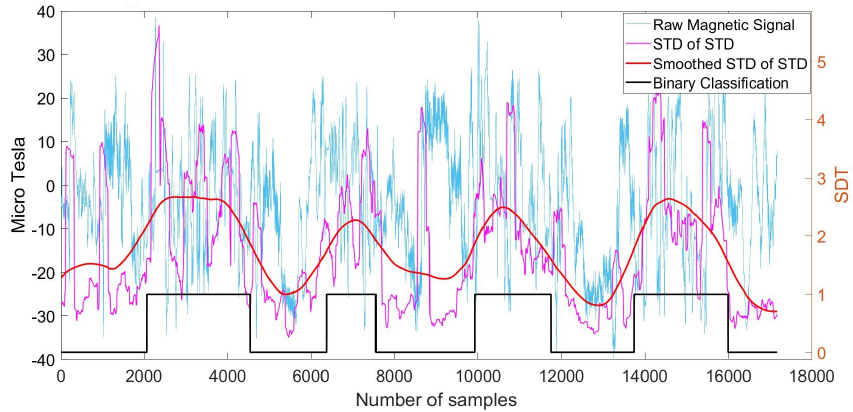
Figure 10. Magnetometer signal from walking into four consecutive buildings and corresponding smoothed moving STD of the disturbance, with kernel size of 200 samples, and the final binary